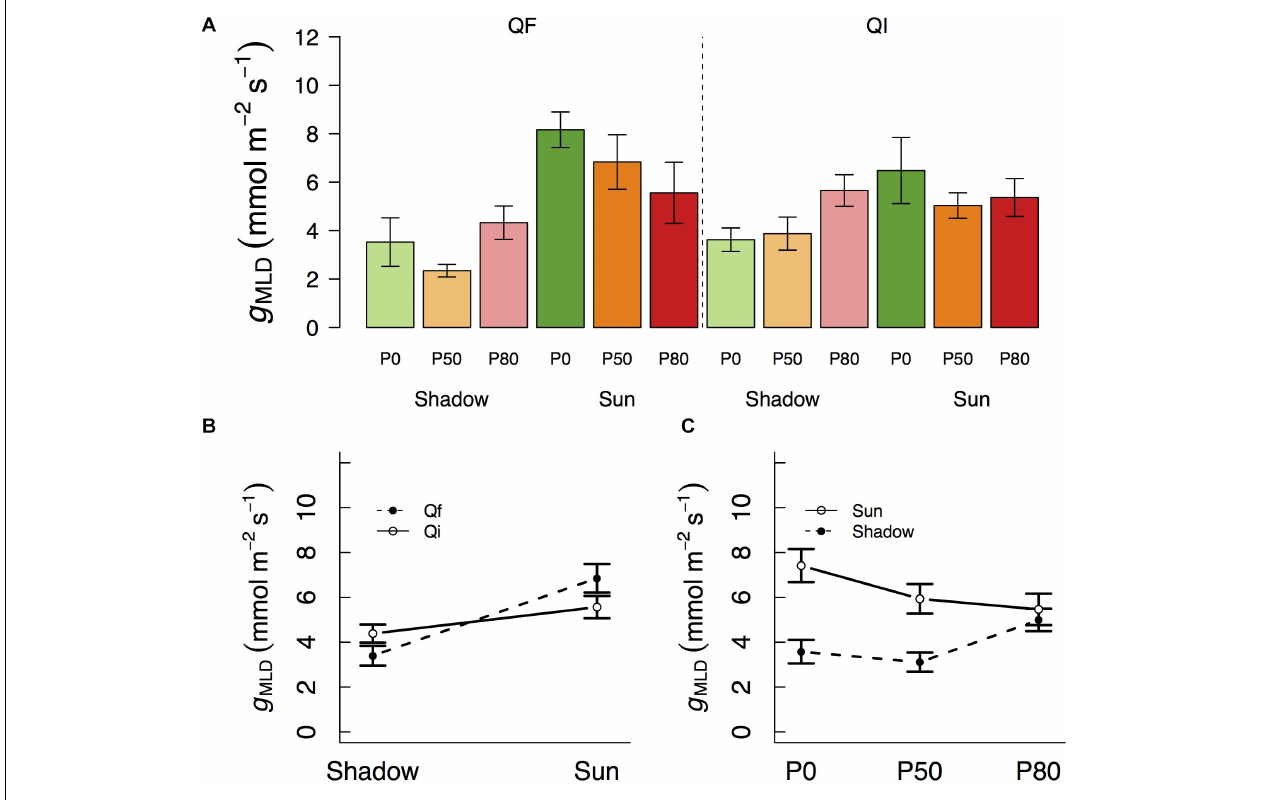
FIGURE 1 | (A) Variation in residual conductance measured from the mass loss of detached leaves (g MLD ) across different light treatments (shadow vs sun) and water treatments (P 0 , P 50 , and P 80 ). Significant interactions across treatments are plotted in (B,C) . Bars indicate mean values per treatment and error bars indicate